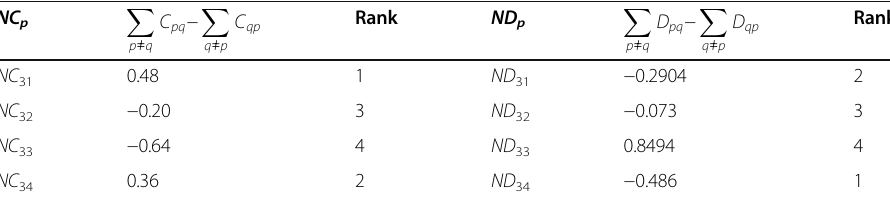
Table 13 Net concordance and discordance